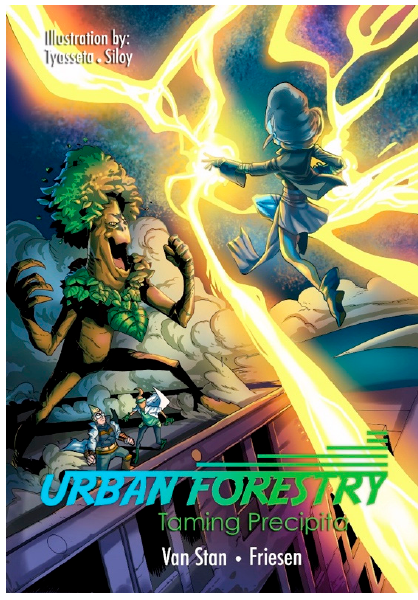
Figure 7. The cover of the forthcoming comic “Urban forestry: Taming Precipita”.